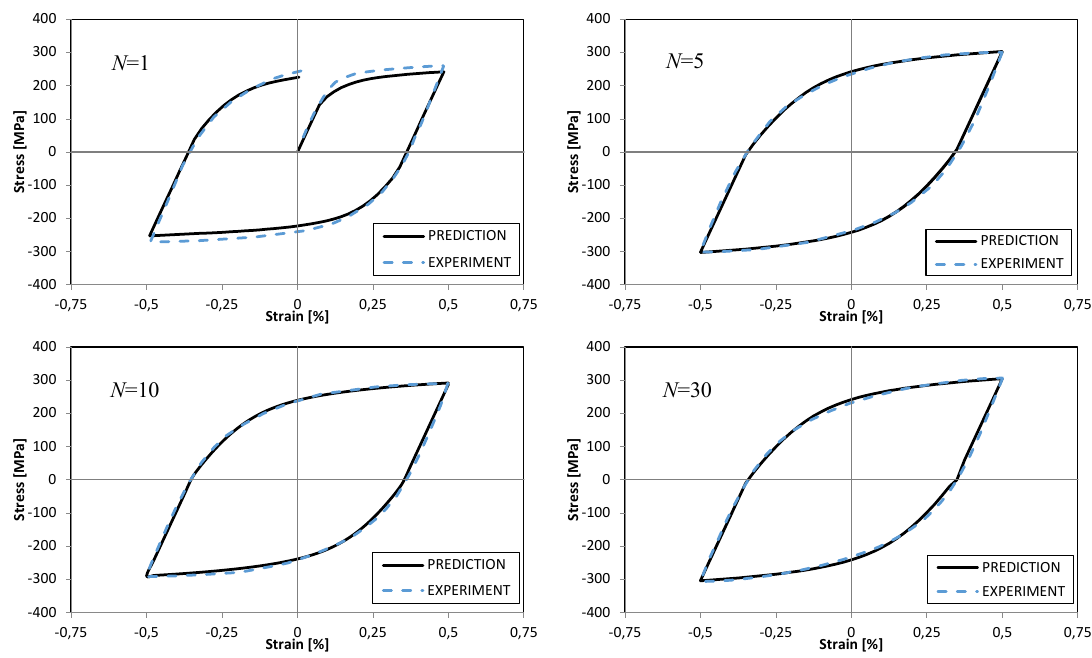
Figure 5. Prediction of the uniaxial test with ∆ (cid:101) = 1% (experimental data were taken from [15]). Another simulation was of a cyclic test with a linearly-increased/-decreased strain amplitude composed of five identical blocks. In each block, the strain range was increased within 20 cycles to a value of 5%, and subsequently, it was reduced, with the same increment. The resulting stress–total strain dependence for the strain range increasing stage is shown in Figure 7. The increasing amplitude of the stress was more progressive in the prediction than in the experiment, as can also be seen in Figure 8. Figure 8 presents a comparison with an experiment, in which the peaks of the hysteresis loops are plotted for the first and fifth loading block. The relative error of the prediction was about 12.3% in the first block (for amplitude of strain 2.5%), but it was reduced to 6.7% in the fifth loading block. The proposed model was able to capture the static and cyclic stress–strain curve for SS304 correctly. It also simulated well the shapes of the stress–strain hysteresis loops in all investigated cases, as well as the Bauschniger effect, which became weaker for higher strain ranges. The non-Masing behavior of the SS304 material was very strong, and this can be modeled better with superposition of the kinematic hardening and isotropic hardening, as in the proposed constitutive model. For the incremental test, the prediction was very good, especially in the fifth loading block. The overprediction of the peak stresses in the first block of loading can be reduced, for example, by introducing memory surface contraction, as was proposed in the original model of Jiang and Sehitoglu